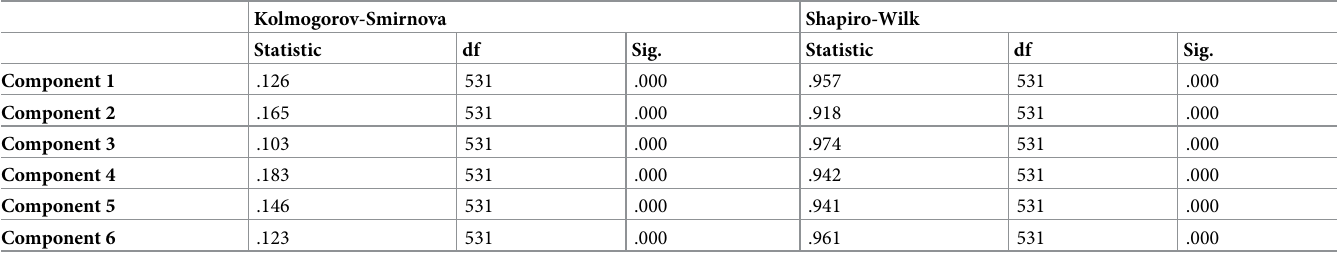
Table 4. Normality